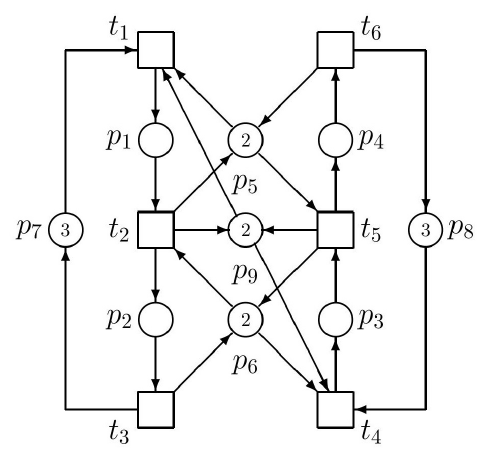
Figure 3. The controlled PN model of the